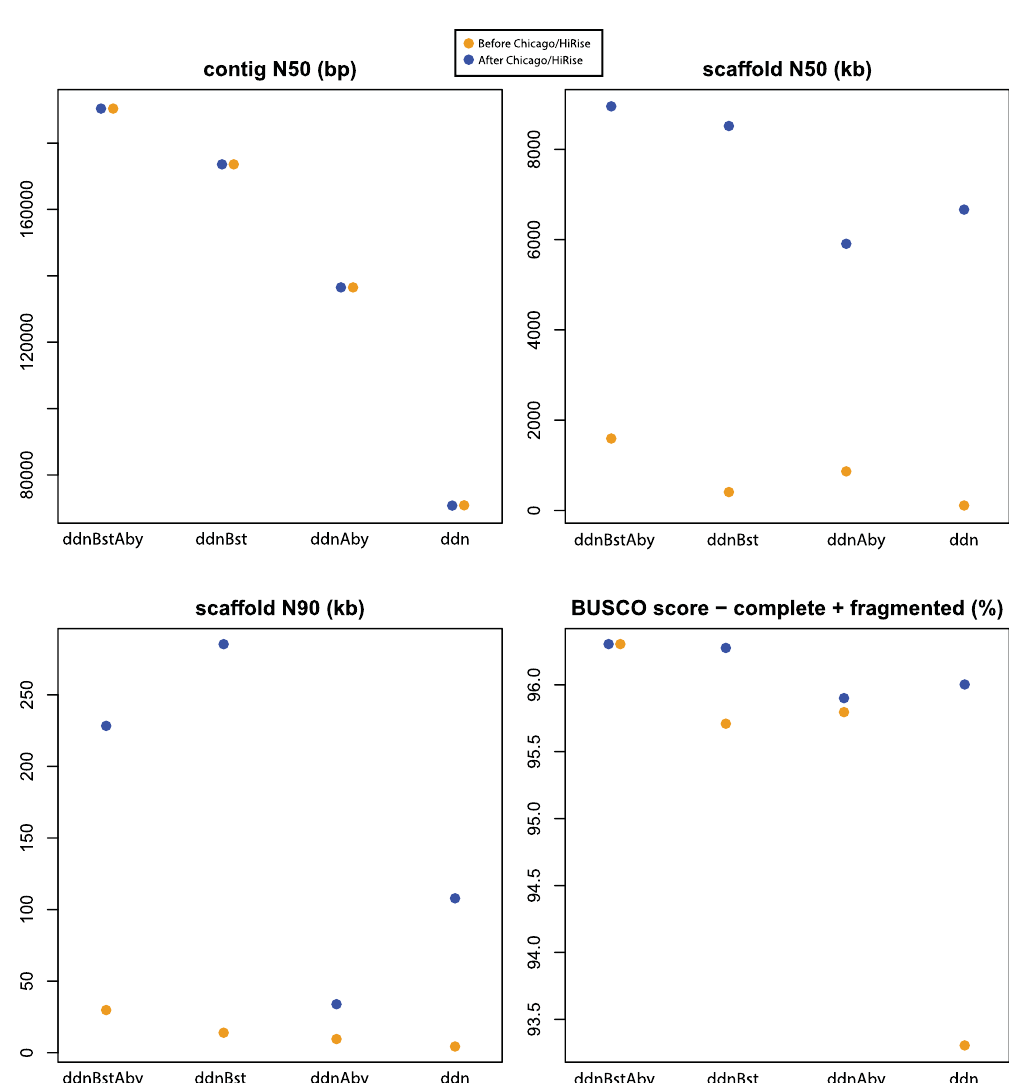
Figure 2. Flow chart of each of the eight candidate assemblies. Colored ovals represent each of the eight assemblies with color indicating which sources of DNA were used. The bold oval represents our highest scoring and final assembly C_vrolikii_CAS243847_v1.0.